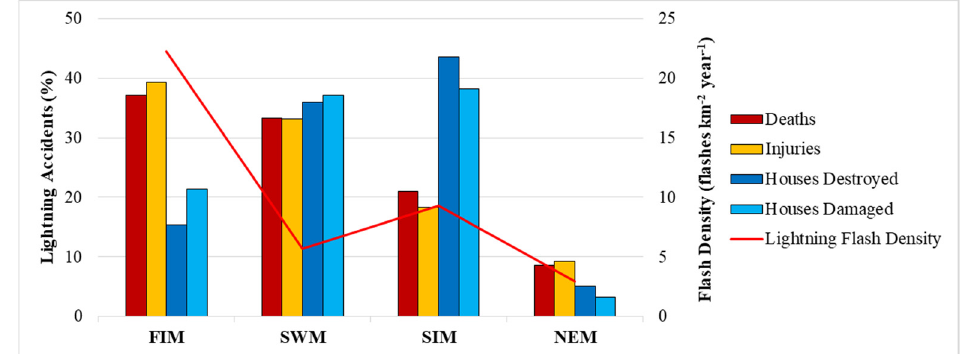
Figure 6. Graphical overview of the seasonal variations of lightning accidents in Sri Lanka, from 1974 to 2019. Table 8. Statistics of the seasonal variations of lightning accidents in Sri Lanka, from 1974 to 2019. Deaths